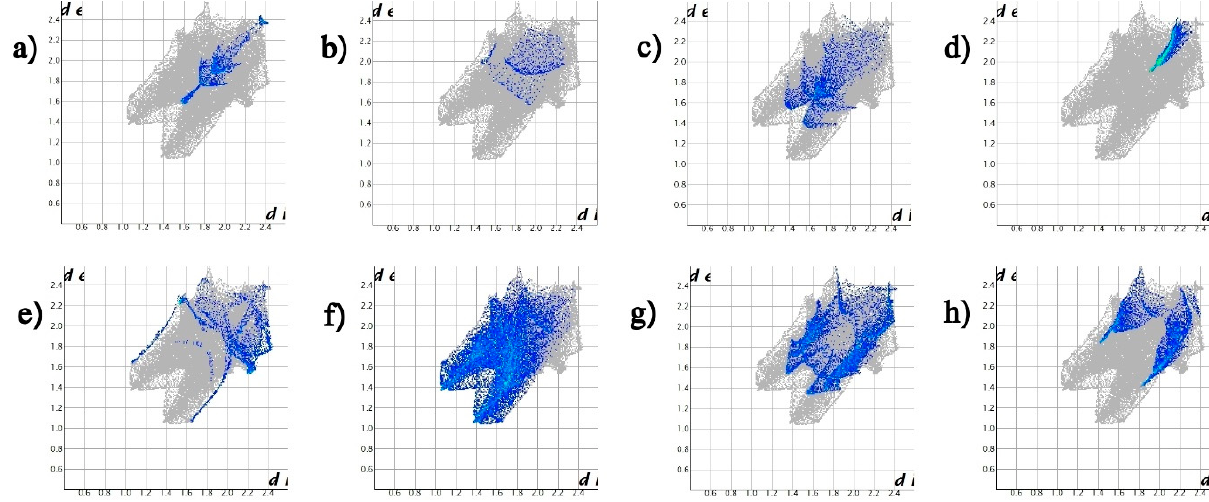
Figure 9. Hirshfeld fingerprint plots of compound 4 for ( a ) C···C, ( b ) H···H interactions, ( c ) O···O, ( d ) S···S, ( e ) C–H/H–C, ( f ) O–H/H–O, ( g ) C···O/O···C and ( h ) O···S/S···O interactions.